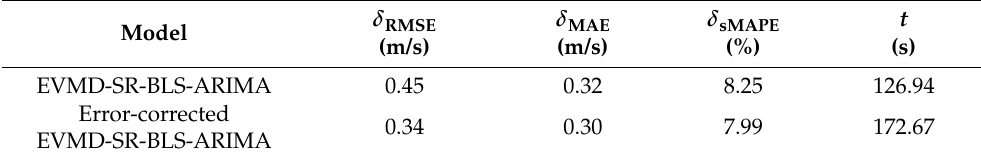
Figure 15. Wind speed forecasting results of EVMD-SR-BLS-ARIMA model. Table 4. Evaluation indexes by EVMD-SR-BLS-ARIMA